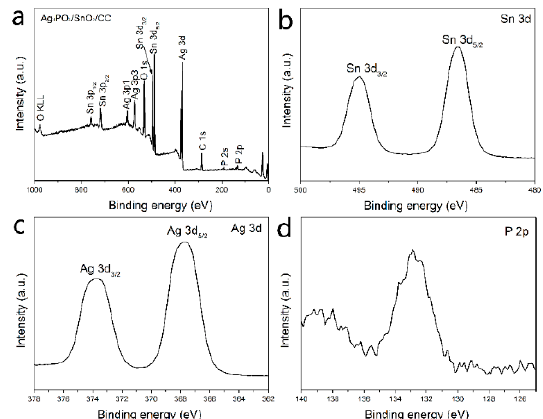
Figure 5. XPS spectra of the Ag 3 PO 4 /SnO 2 /CC: ( a ) survey spectrum, ( b ) Sn 3d, ( c ) Ag 3d, ( d ) P 2p.